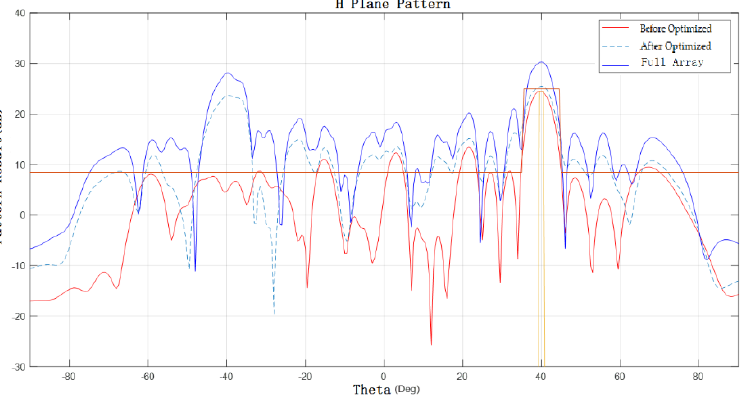
Figure 9. H-plane orientation of the array after optimization of the subarray amplitude–phase distribution at 40-degree scan angle.